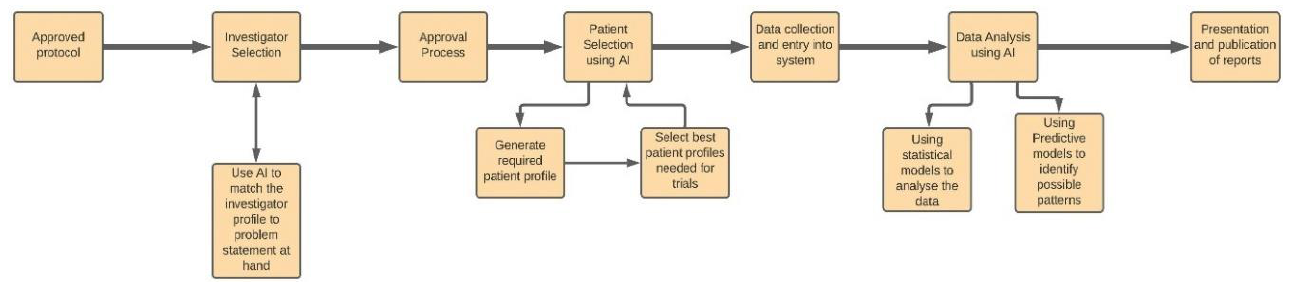
Figure 8. The Process Flow Representation of AI in Clinical Trials.